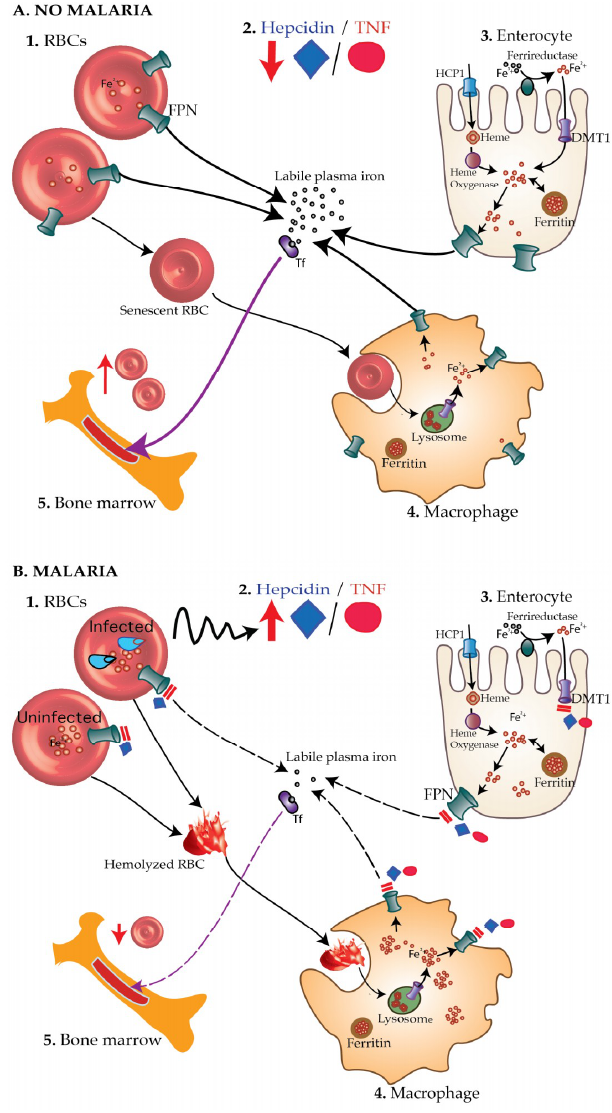
Figure 1. The malaria—iron deficiency hypothesis. ( A ) In healthy children without malaria ( A1 ), concentrations of hepcidin and TNF- α are low ( A2 ) leading to increased absorption of iron through enterocytes ( A3 ), reduced hemolysis of RBCs and increased recycling of iron recovered from senescent RBCs by macrophages ( A4 ). More iron is thus available for the production of new RBCs ( A5 ). ( B ) On the other hand, during malaria infection, blood‑stage malaria parasites ( B1 ) elicit increased production of hepcidin and TNF‑α ( B2 ), which, in turn, block absorption of iron through DMT1 and ferroportin (FPN) on enterocytes ( B3 ). Hepcidin also degrades ferroportin on both infected and uninfected RBCs leading to accumulation of intracellular iron, oxidative stress, and consequently hemolysis. Hemolyzed RBCs are taken up by the macrophage ( B4 ). Hepcidin and TNF- α inhibit recycling of iron recovered from hemolyzed RBCs back into the circulation leading to deficiency of the amount of biologically available iron. Consequently, little iron is available to produce new RBCs by the bone marrow leading to iron deficiency anemia ( B5 ). Tf, transferrin.